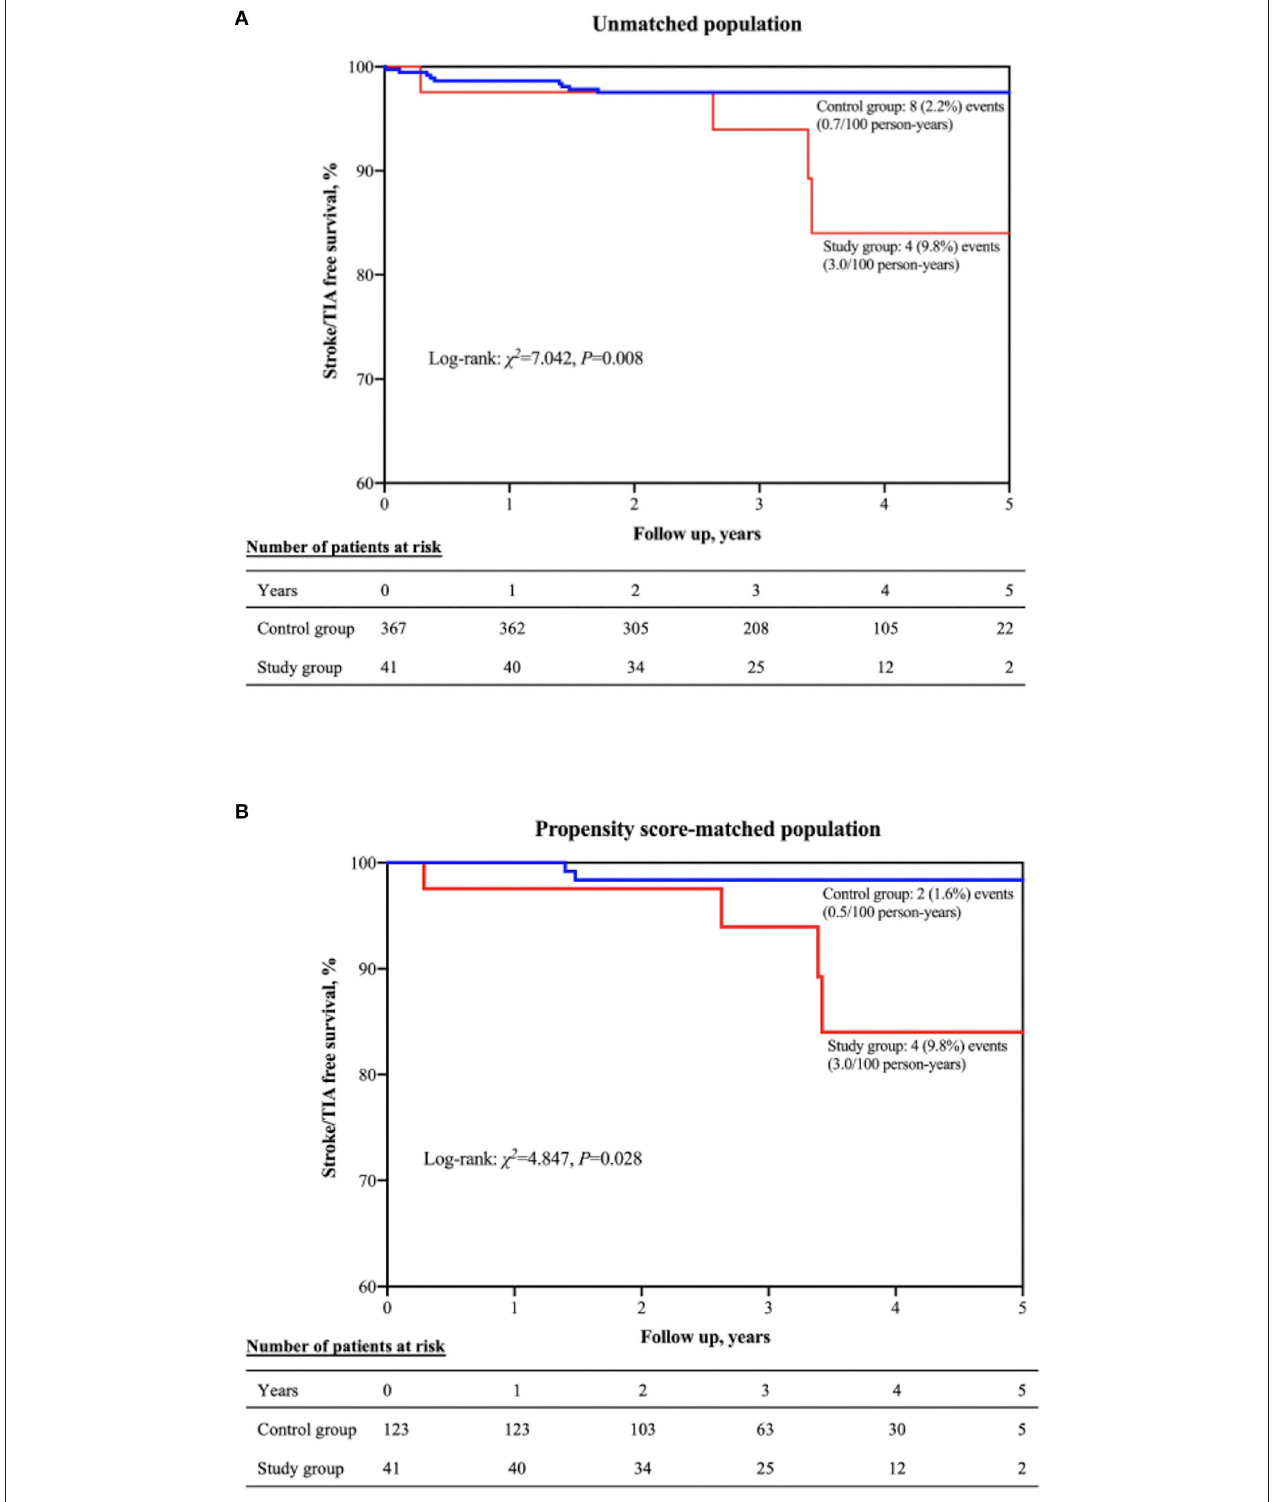
FIGURE 4 | Kaplan-Meier curve showing stroke/TIA–free survival in the unmatched (A) and propensity score-matched (B) populations. TIA, transient ischemic attack.